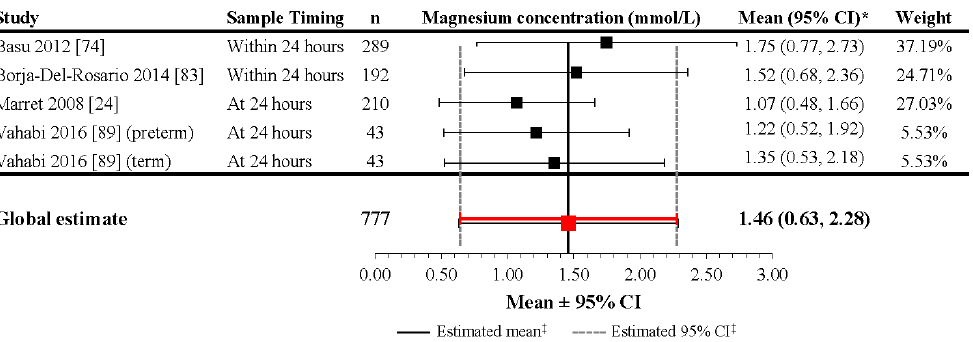
Figure 5. Magnesium concentrations during the first day of life in newborns with magnesium supplementation during pregnancy. * If 95% CIs were not reported in the study, then the 95% CIs were calculated as follows: mean ± (1.96 × SD). ‡ Reference line and 95% CI derived using only studies reporting both mean and SD data. Overall statistic for heterogeneity: I 2 = 99.5% ( p < 0.001). CI: confidence interval; n: number of infants; SD: standard deviation.